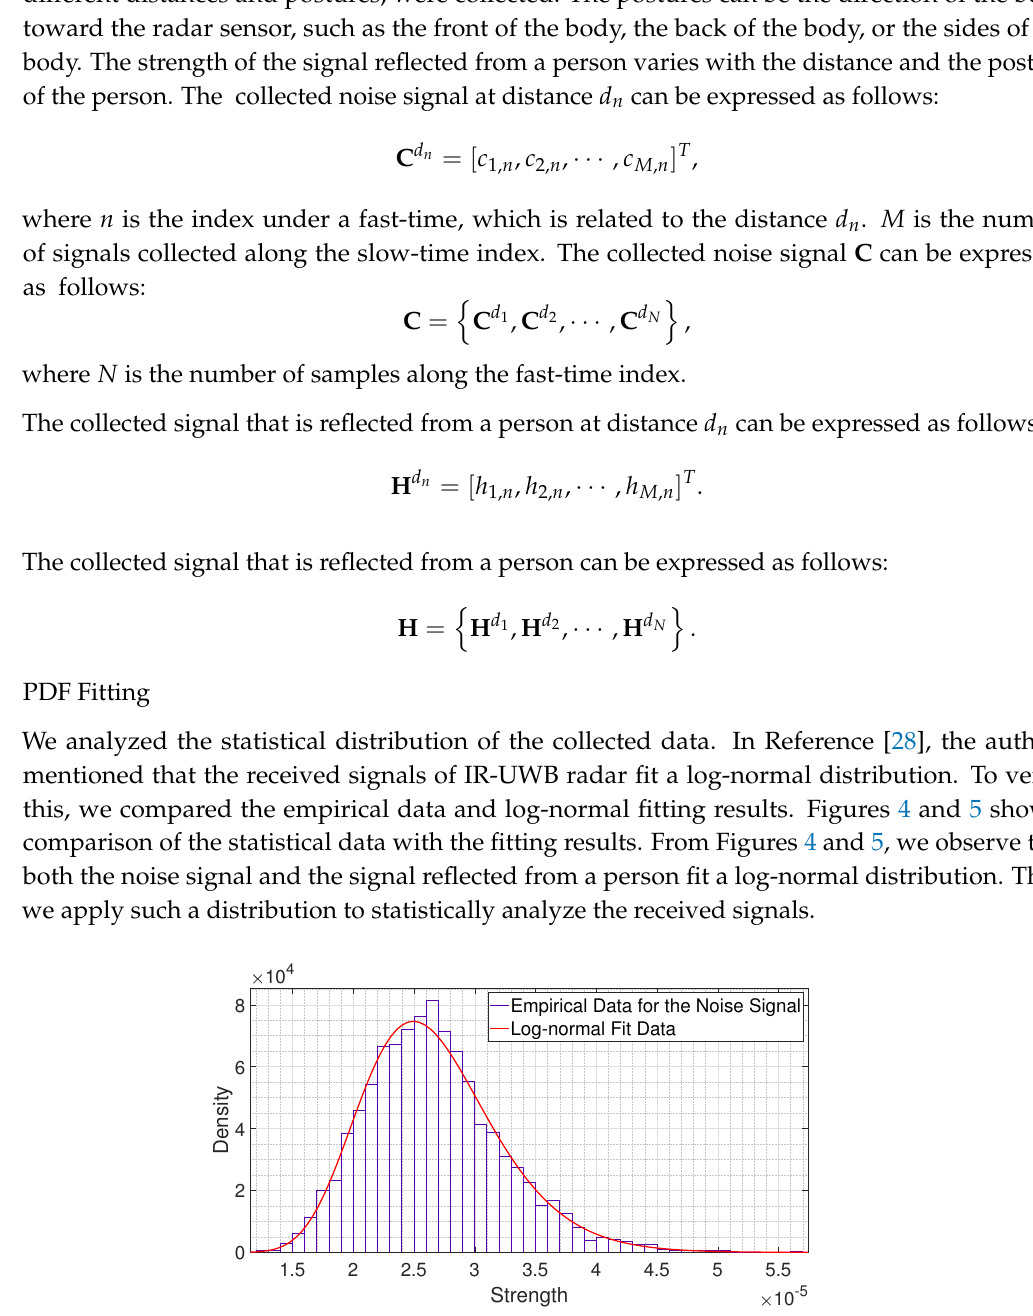
Figure 4. Comparison of the statistical data on the empirical strength with the fitting result for the noise